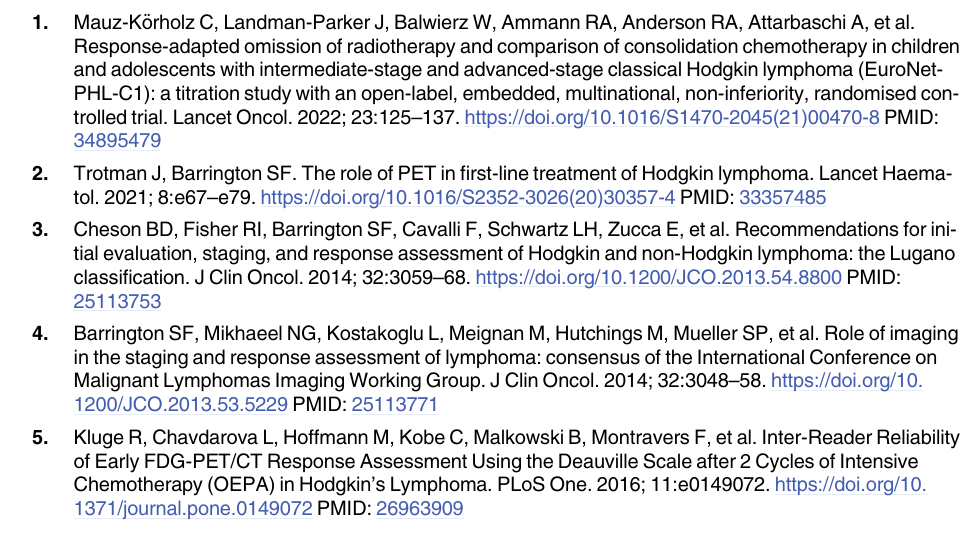
S1 Table. Comparison of the quantitative Deauville score (qDS) in major visual discrepan-